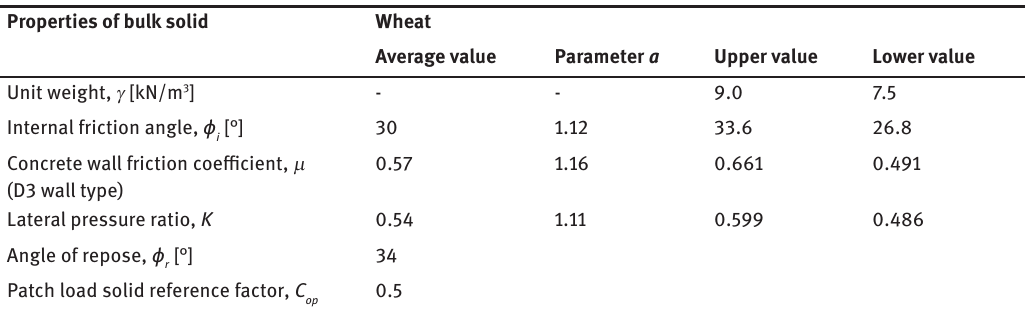
Table 4: Physicomechanical properties of wheat adopted to determine the pressure in the silo chamber according to Eurocode 1, Part 4, Annex E